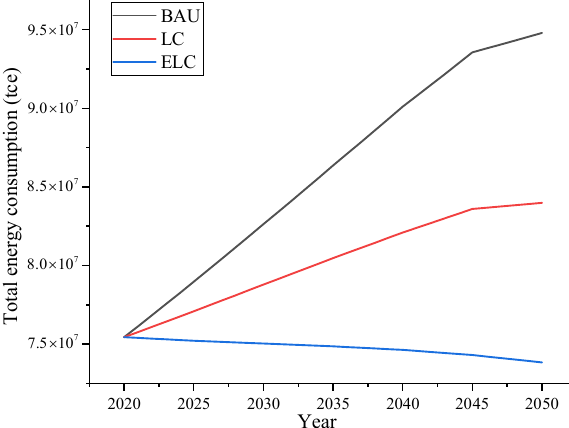
Figure 2. Prediction of total energy consumption in Beijing.